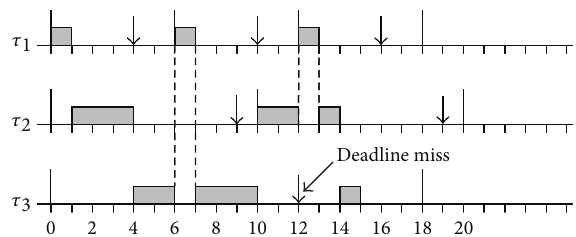
Figure 6: Implicit reconfiguration process.